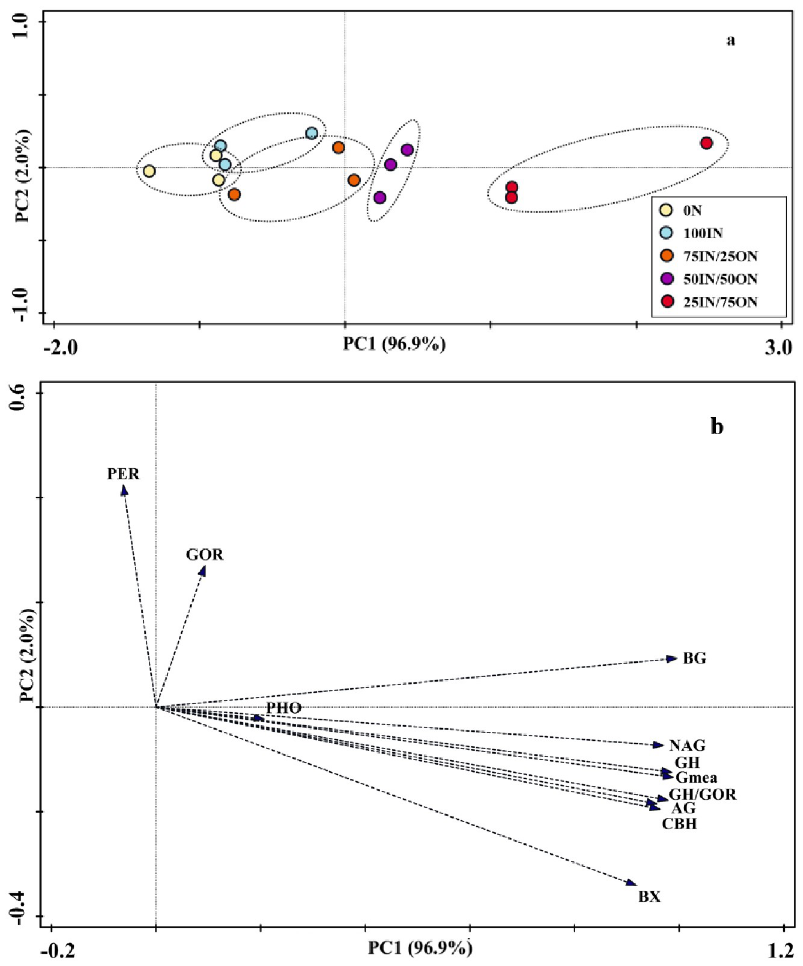
Fig 3. Principal component analysis (PCA) of soil extracellular enzyme activity profiles (a), and loading values for individual soil extracellular enzyme activities (b) from different fertilizer